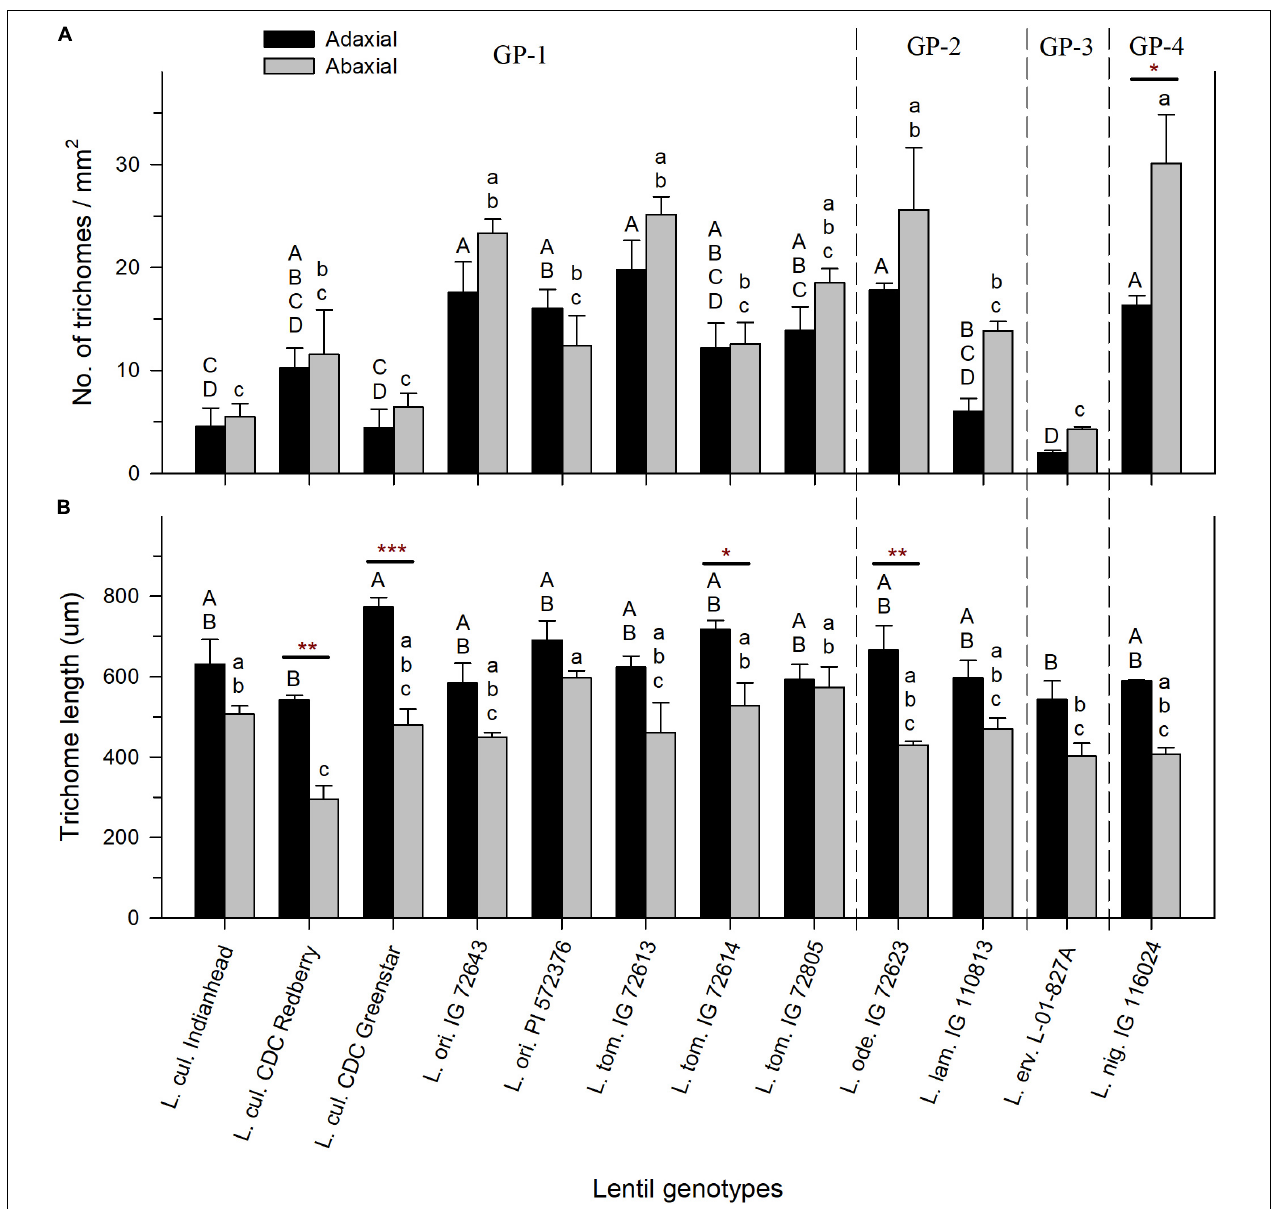
FIGURE 3 | Mean trichome density expressed as the number of trichomes per mm 2 (A) and mean trichome length in micrometers (B) on the adaxial and abaxial leaflet surfaces of cultivated and wild lentil genotypes. Asterisks indicate statistical difference between mean density of adaxial and abaxial surfaces of the